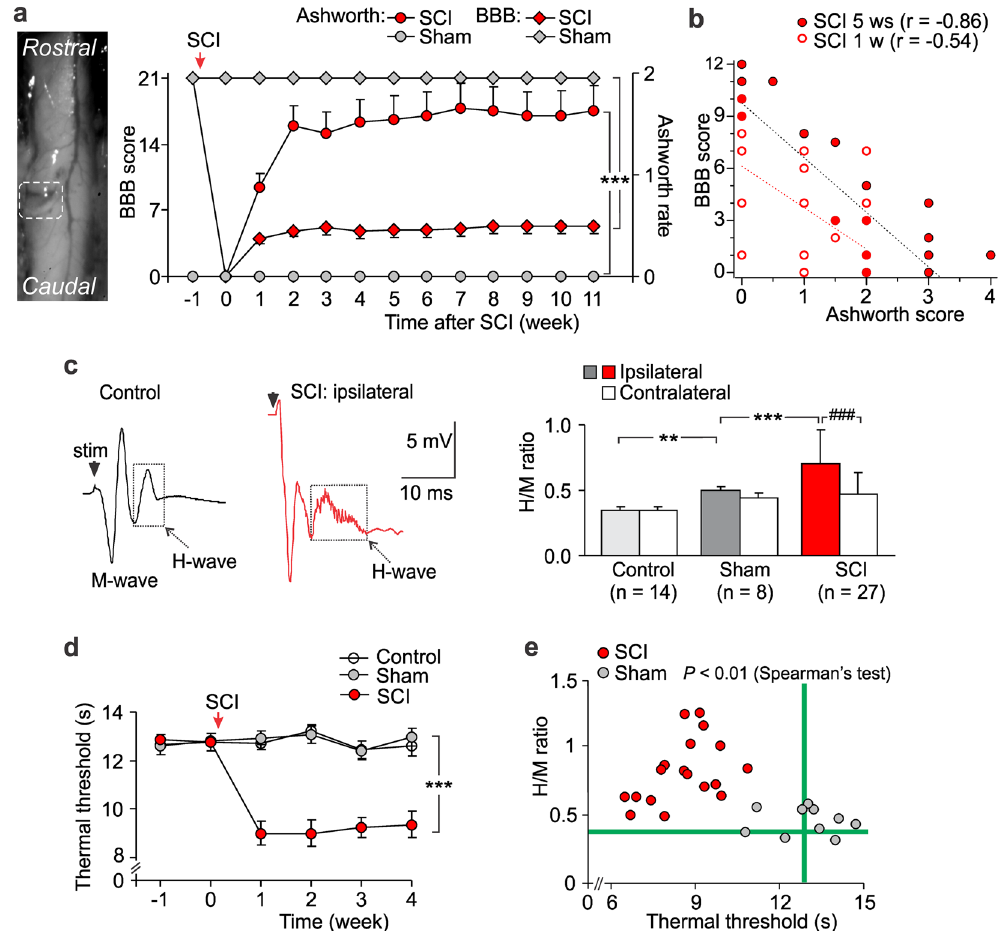
Figure 1. The SCI-induced spasticity correlates with chronic pain. ( a ) Left, image of the spinal cord immediately after the lesion (white box indicates the lesion site, Th 11 ). Right, summary of the BBB (left Y axis) scaling of animal locomotion and the Ashworth rate (right Y axis) of long-lasting impairments in muscle tone on the ipsilateral side postoperatively (n = 32 SCI-injured rats, n = 14 sham-operated animals). *** P < 0.001 (two-way repeated analysis of variance and Bonferroni post-hoc test). ( b ) The BBB score estimated for each animal at week 1 and week 5 post-SCI (n = 32 animals) plotted against its Ashworth scoring value. The Pearson correlation coefficients (r) are indicated. ( c ) Left, examples of the H-reflex recordings, demonstrating the M- and the H-wave responses in control and post-SCI at ~1 month postoperatively. Right, the ratio of the H- to the-M-wave amplitudes in different experimental groups. ### P < 0.001 (paired t -test), ** p < 0.01, *** p < 0.001 (unpaired t -test). ( d ) The time course of changes in the thermal nociceptive threshold of the ipsilateral hindpaw in different groups of animals, demonstrating experiencing of the long-lasting pain post-SCI (n = 11 control, n = 14 sham-operated rats and n = 15 animals post-SCI). *** P < 0.001 (ANOVA with Bonferroni post-hoc test). ( e ) The H-reflex measurements (the H/M ratio) plotted against the thermal nociceptive threshold estimated for a respective animal at the time-point of ~1 month postoperatively for the sham-operated (n = 10 animals) and the SCI groups (n = 18 animals). The Spearman’s test significance is indicated. Green lines indicate the average parameters in control animals (no surgery). Data are expressed as mean; error bars,